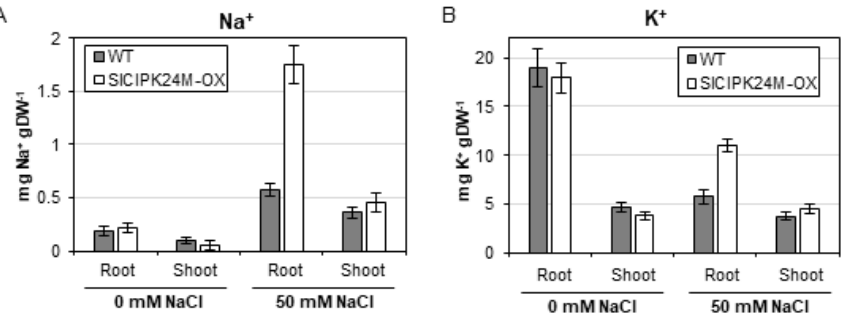
Figure 8. Na + ( A ) and K + ( B ) contents in roots and shoots of wild-type and SlCIPK24M- overexpressing tomato plants. Eleven-day-old seedlings were treated with 0 or 50 mM NaCl solution (1/6 MS) for five additional days. For each condition, three plants were harvested and pooled in roots and shoots for the measurement of Na + and K + contents. Error bars denote standard deviation (SD) of three biological replicates. Values are significantly different (the Student’s t -test, p ≤ 0.05).